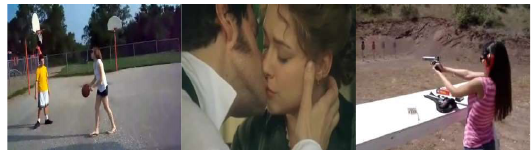
Figure 25. Samples from HMDB51 dataset [235].